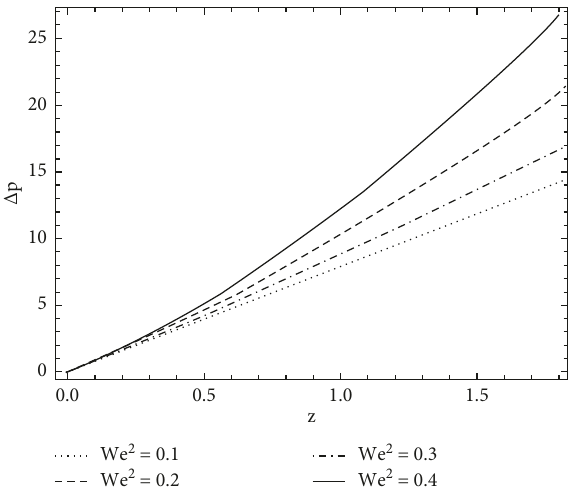
Figure 8: Varian of mean pressure drops ∆ p with z for different values of We 2 , where P 0 � 43, K � 0.001, n � − 1, and m � 0.5.